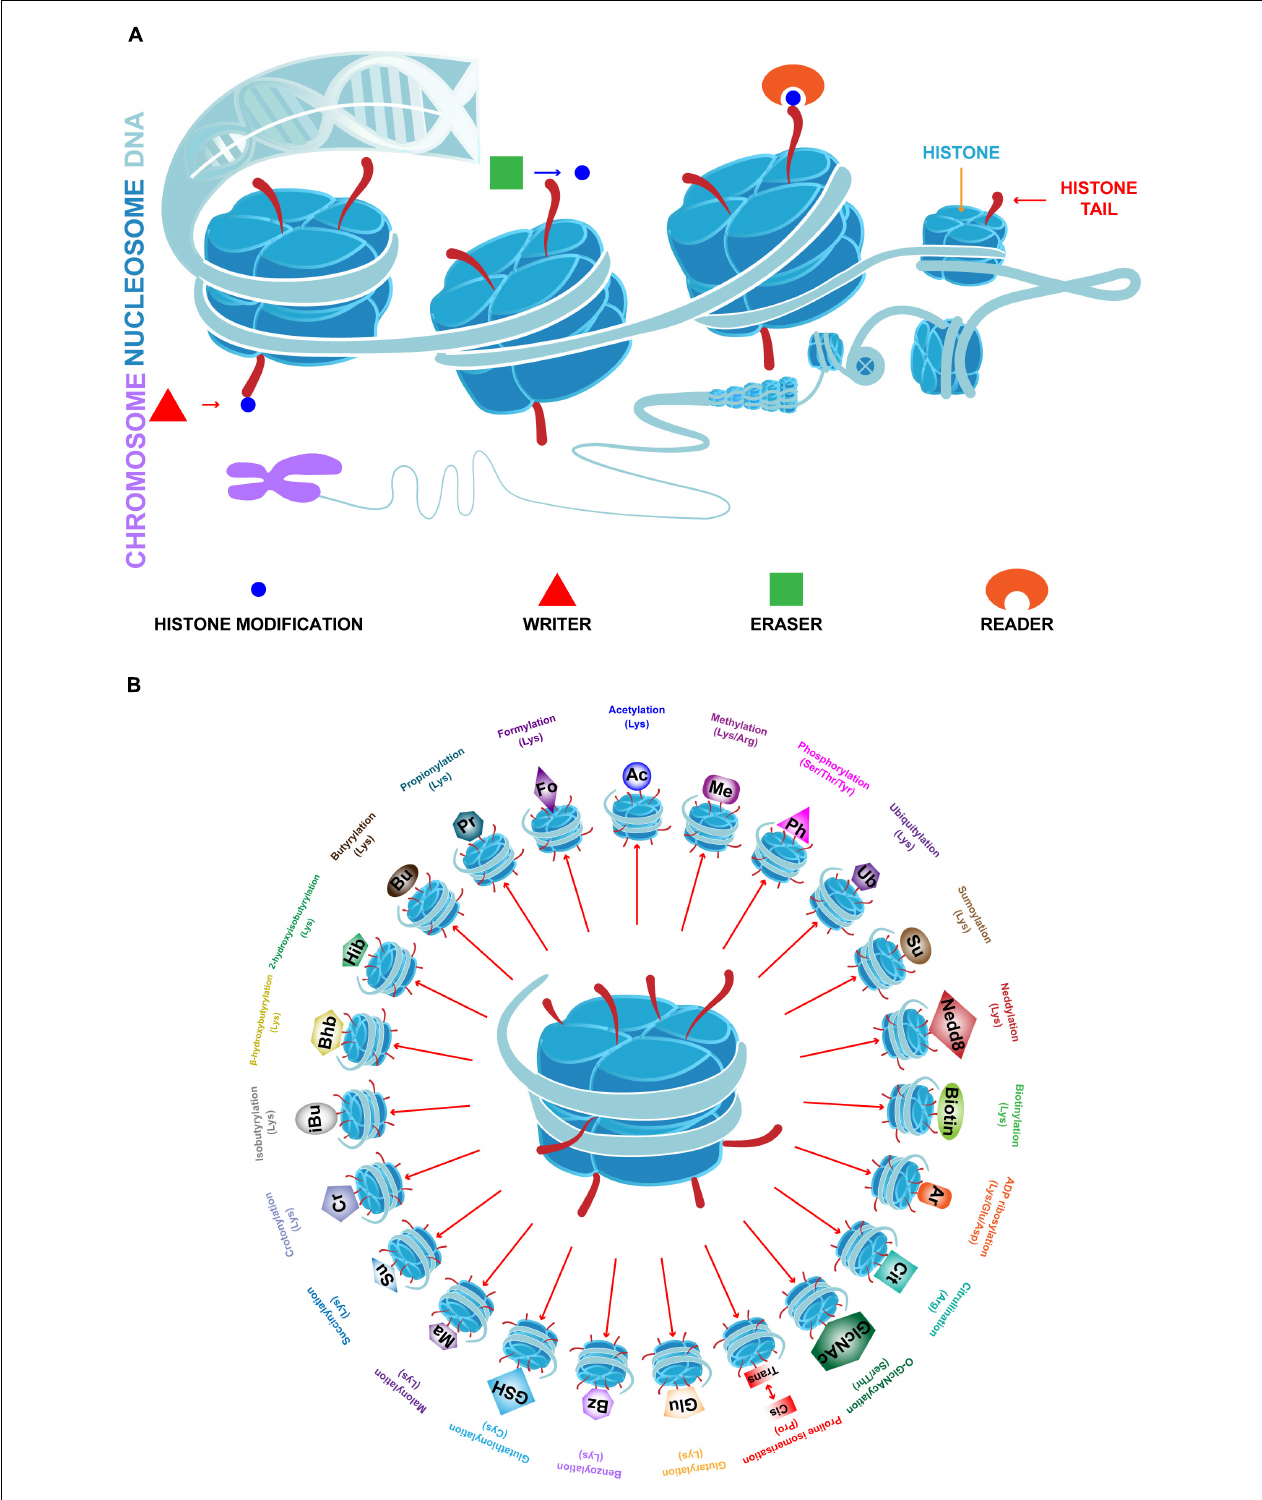
FIGURE 1 | Chromatin structure and 23 classes of HMs. (A) In eukaryotic cells, chromatin is the complex formed by DNA and histones. The basic functional unit of chromatin is the nucleosome which contains a histone octamer (H2A, H2B, H3, and H4) which is wrapped by DNA. Histone tails undergo numerous posttranslational modifications, which are deposited by writers, removed by erasers and read by readers, and may either loosen or tighten DNA-histone binding which active or silence transcription. (B) Specific HMs and modified amino acids are indicated.